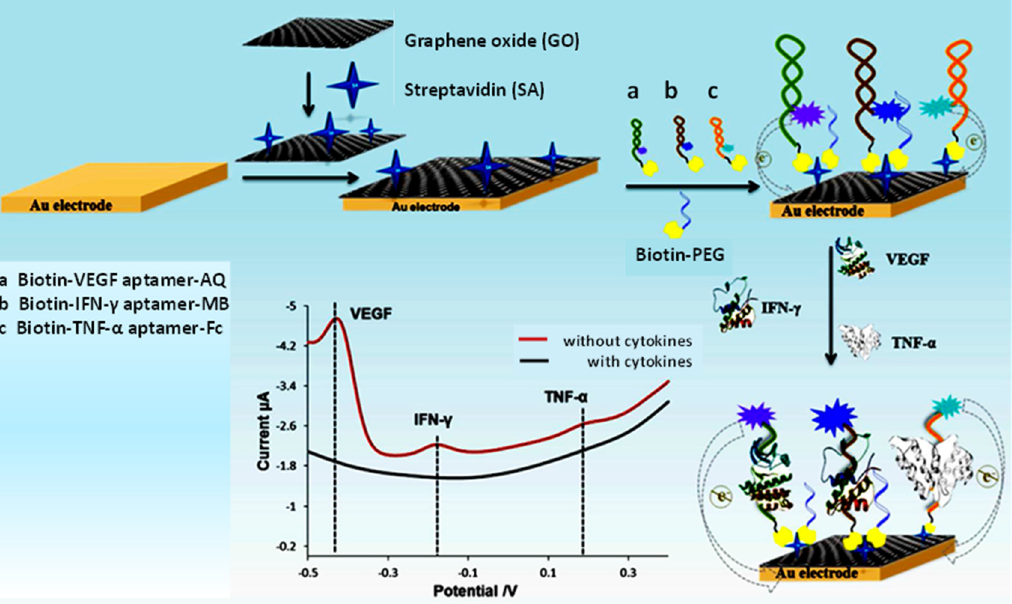
Figure 8. Schematic of an electrochemical aptasensor for the simultaneous and real-time monitoring of VEGF, IFN- γ and TNF- α . Reproduced from [126] with permission.